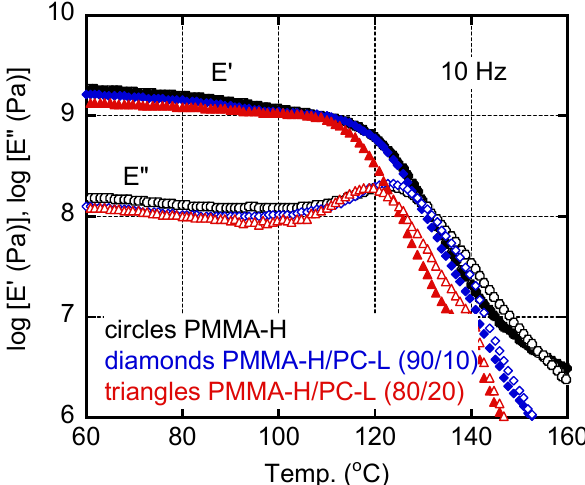
Figure 4. Temperature dependence of (closed symbols) tensile storage modulus E′ and (open symbols) loss modulus E″ at 10 Hz; (circles) PMMA-H, (diamonds) PMMA-H/PC-L (90/10), and (triangles) PMMA-H/PC-L (80/20).